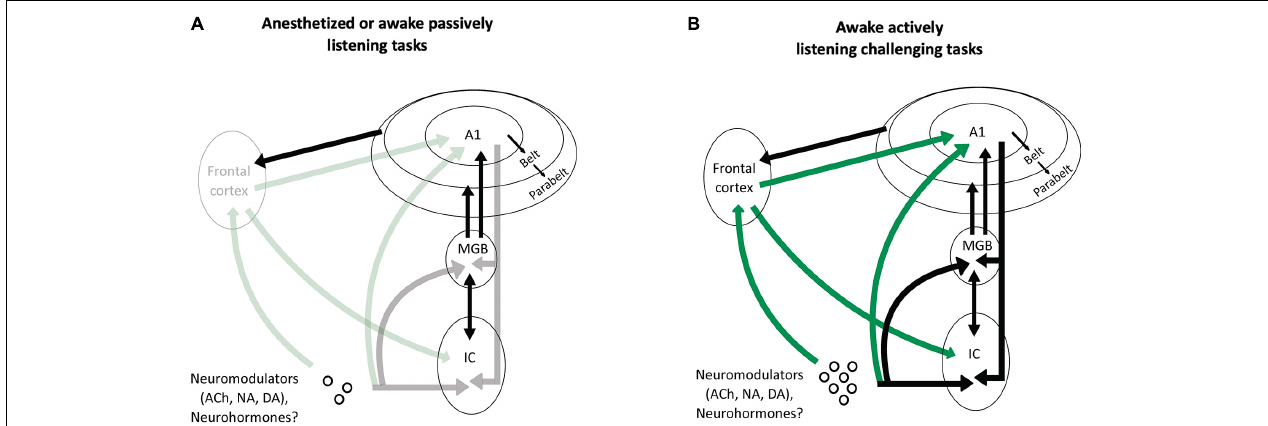
FIGURE 5 | Potential scenarios involving frontal projections and neuromodulators as key factors to increase the impact of the cortical descending projections on the thalamus and the inferior colliculus. (A) In anesthetized animals, or in awake passively listening animals performing easy auditory tasks, there is no or little activation of the frontal areas and of the neuromodulatory systems (symbolized by the shaded arrows). As a consequence, the descending projections from auditory cortex have a negligible effect on the processing of acoustic information by subcortical auditory structures (MGB and IC). (B) In awake actively listening animals performing challenging tasks, there is a strong activation of the frontal cortical areas and neuromodulatory systems (symbolized by the solid green lines). This activation sends a strong input to modulate the activity of the auditory cortex, which in turn, reshape the subcortical network (MGB and IC) thus allowing to perform successfully during this